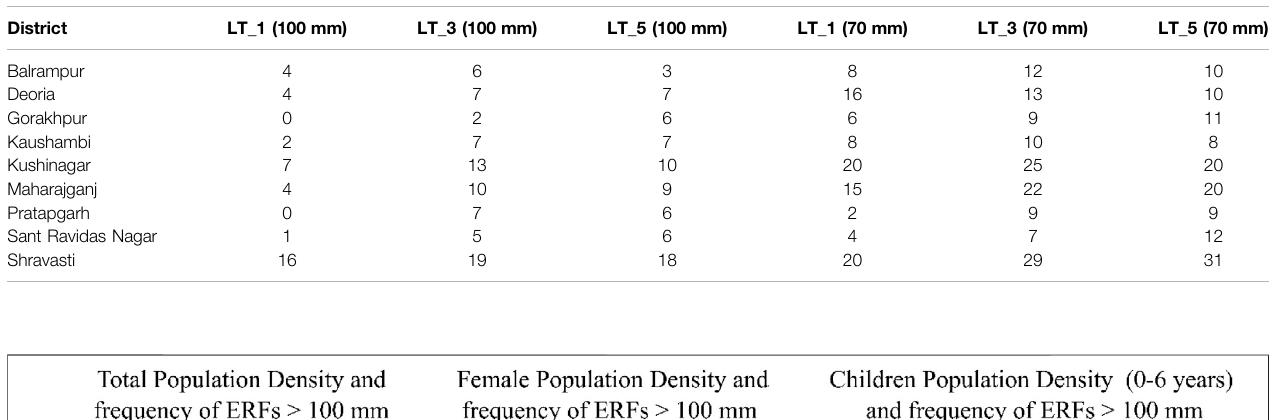
TABLE 1 | Districts observed to receive frequent ERFs during 2017 – 2020.